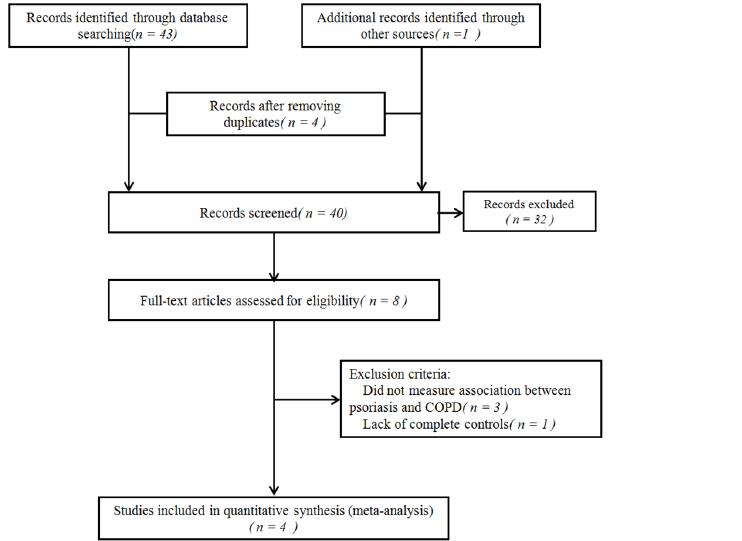
Fig 1. Literature search and study